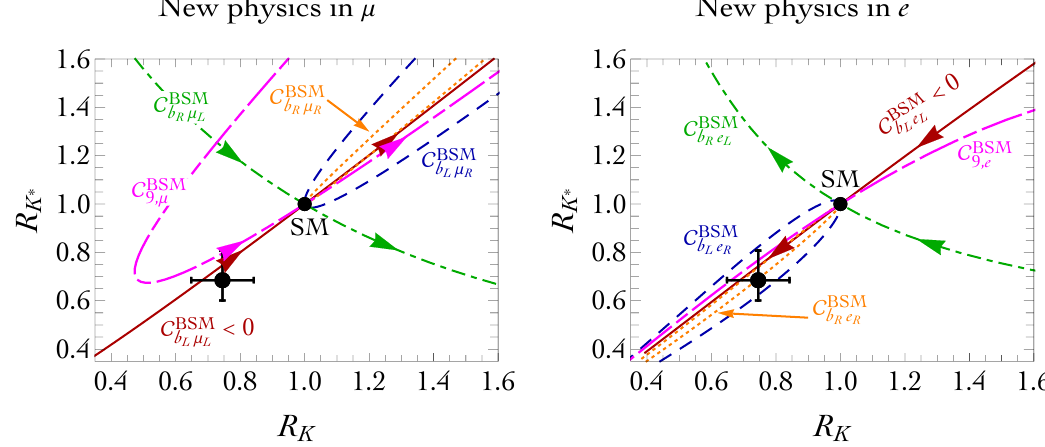
Figure 1 . Deviations from the SM value R K = R K (cid:3) = 1 due to the various chiral operators possibly generated by new physics in the muon (left panel) and electron (right panel) sector. Both ratios refer to the [1 : 1 ; 6] GeV 2 q 2 -bin. We assumed real coe(cid:14)cients, and the out-going (in-going) arrows show the e(cid:11)ect of coe(cid:14)cients equal to +1 ( arrows for the coe(cid:14)cients involving left-handed muons and electrons (except for the two magenta arrows in the left-side plot, that refer to C BSM B s (cid:22)(cid:22) is not included in this plot. !